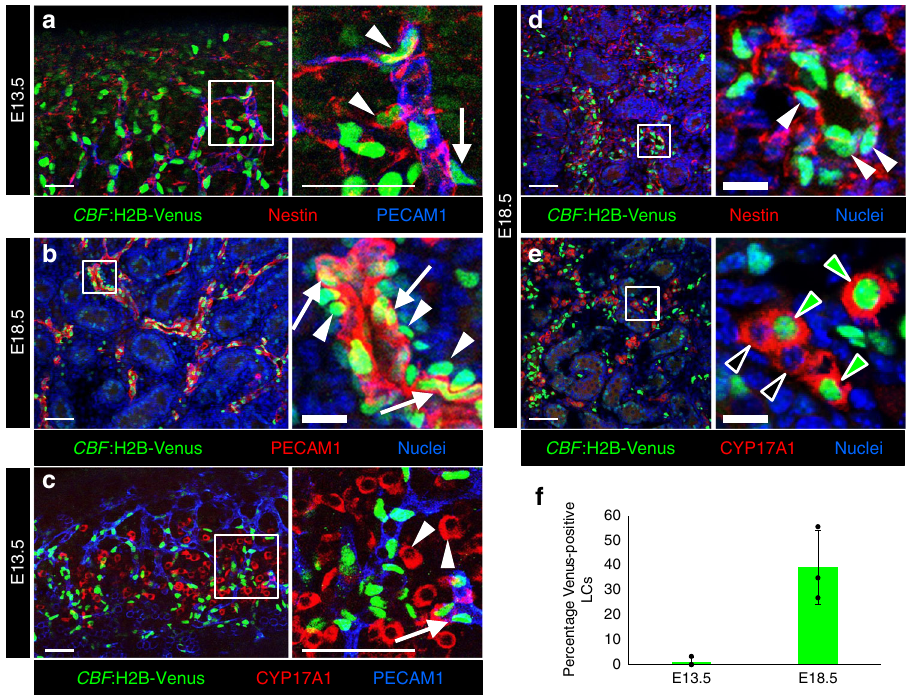
Fig. 6 Active Notch signaling in the fetal testis. a – e Immuno fl uorescence images of E13.5 ( a , c ) and E18.5 ( b , d , e ) fetal testes from CBF :H2B-Venus embryos. a , b A subset of PECAM1-positive endothelial cells (arrows) and Nestin-positive cells adjacent to the vasculature (arrowheads) were Venus- positive. c The initial cohort of FLCs (CYP17A1-positive; arrowheads) was negative for Venus, while vasculature-associated cells (arrow) expressed Venus. d , e At E18.5, Nestin-positive cells expressed Venus ( d , arrowheads), while differentiated FLCs were either Venus-positive ( e , green arrowheads) or Venus- negative ( e , black arrowheads). Thin scale bars, 50 μ m; thick scale bars, 10 μ m. f Graph showing the percentage of CYP17A1-positive cells expressing Venus at E13.5 ( n = 264 cells from 3 independent gonads) and E18.5 ( n = 1574 cells from 3 independent gonads). Data are shown as mean ± (Fig. 8b), and immuno fl uorescence analyses did not reveal any noticeable effect on the vasculature in DAPT-treated testes (Fig. 8c).